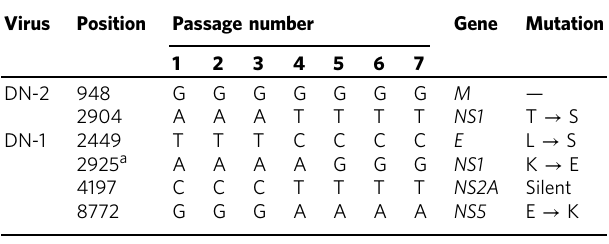
Table 1 Consensus changes in DN-2 and DN-1 after serial passage in Vero cells Virus